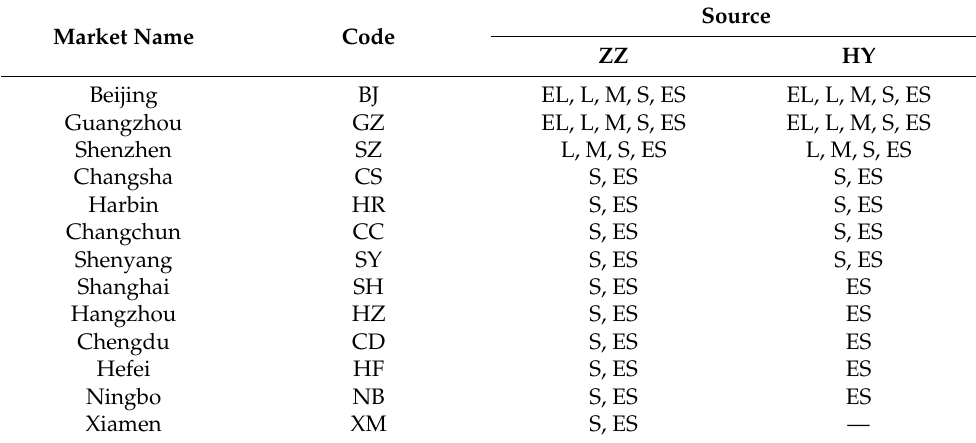
Table 2. Source and market description in wholesale price.